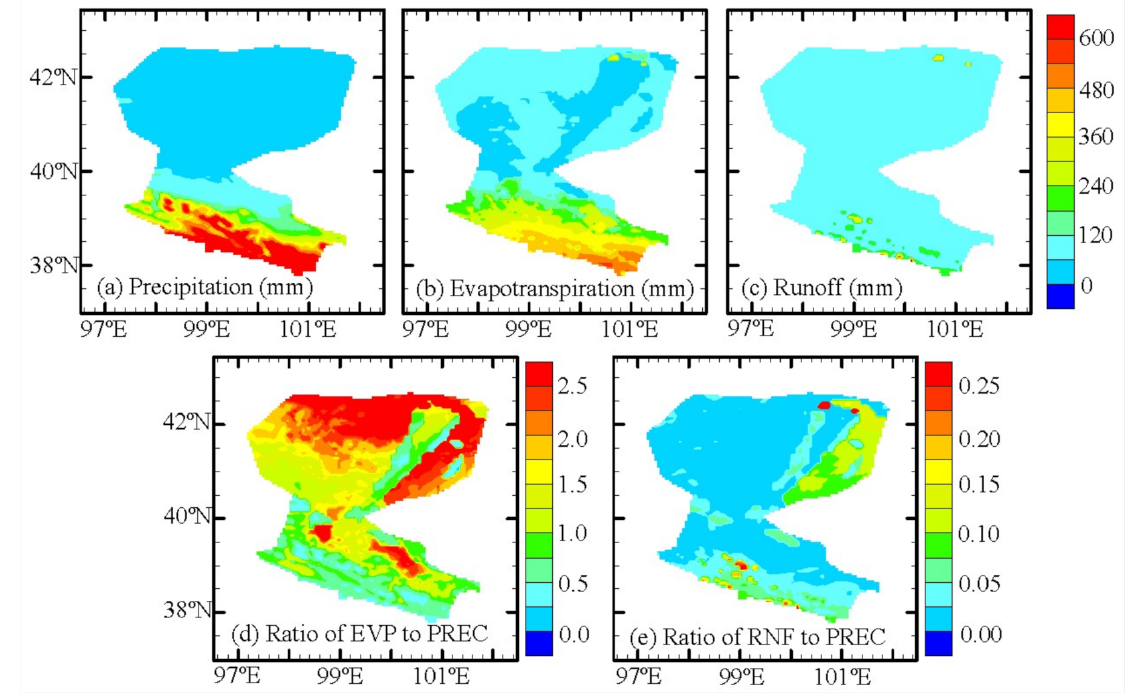
Figure 5. The spatial distribution of the precipitation, evapotranspiration, runoff, and their